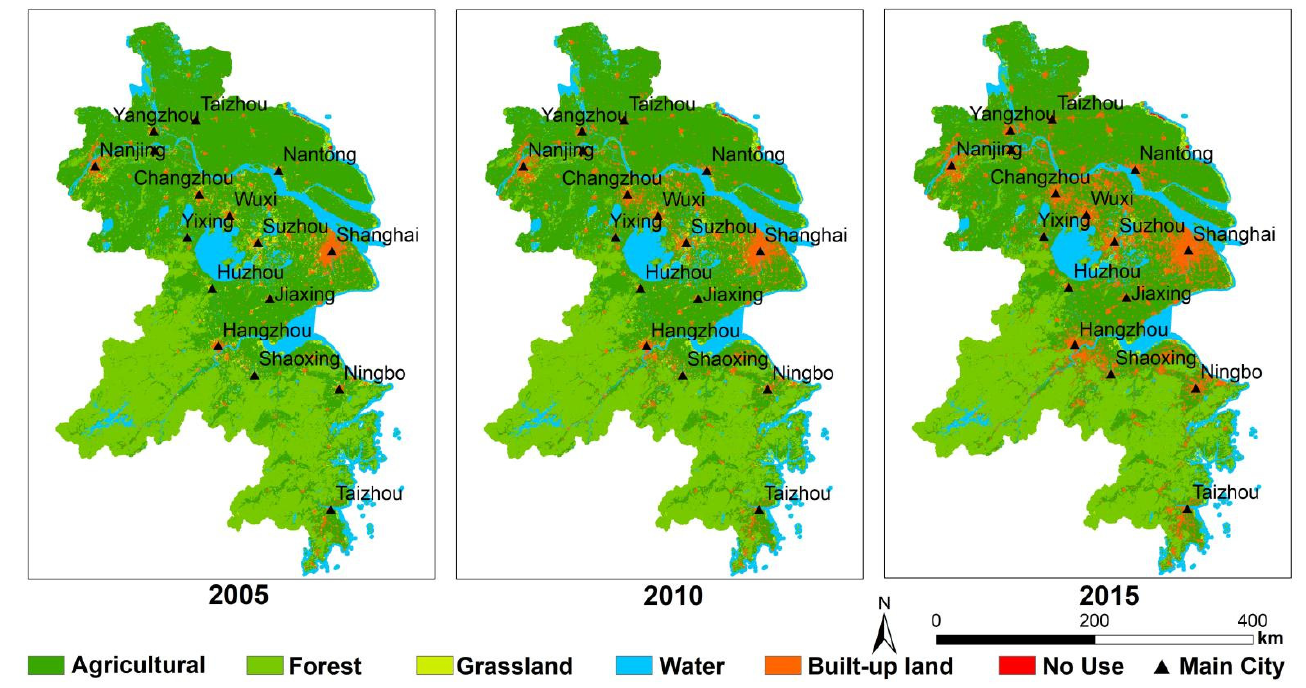
Figure 3. The land ‐ use types of the YRD in 2005, 2010, and 2015. Figure 3. The land-use types of the YRD in 2005, 2010, and